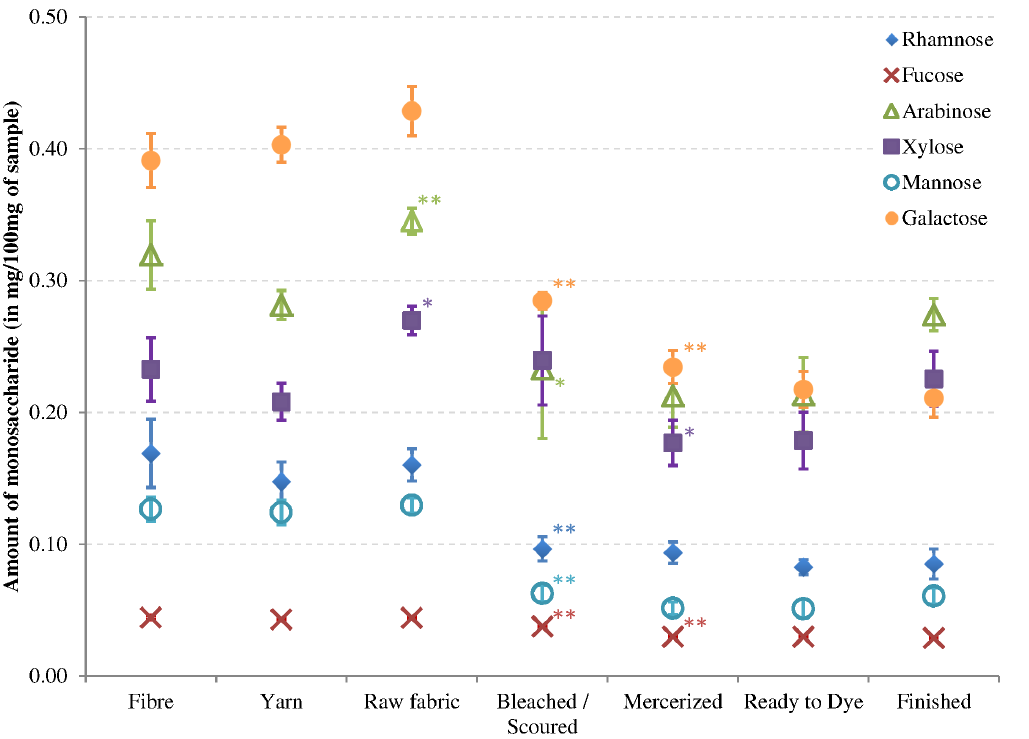
Fig. 2. Amounts of individual neutral monosaccharides in cotton fibre and processed samples. Rhamnose (full diamond), fucose (cross), arabinose (full triangle), xylose (full square), mannose (empty circle) and galactose (full circle) were obtained after hydrolysis of powdered textile processing samples. Error bars represent standard deviation (n 5 3). * and ** indicate significant difference between a sample and the preceding one at p , 0.05 and p , 0.01, respectively.